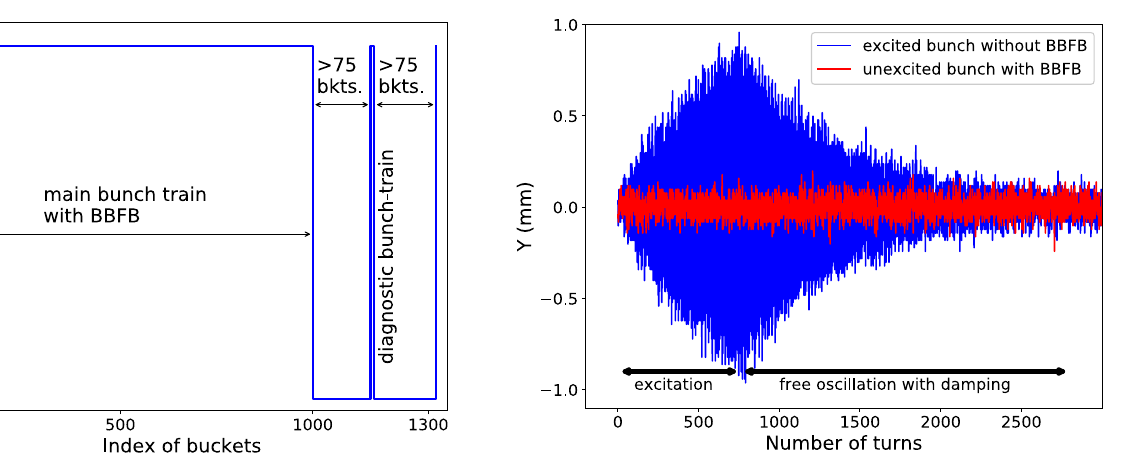
FIG. 1. Bucket filling pattern with an extra DBT for transparent lattice characterization.